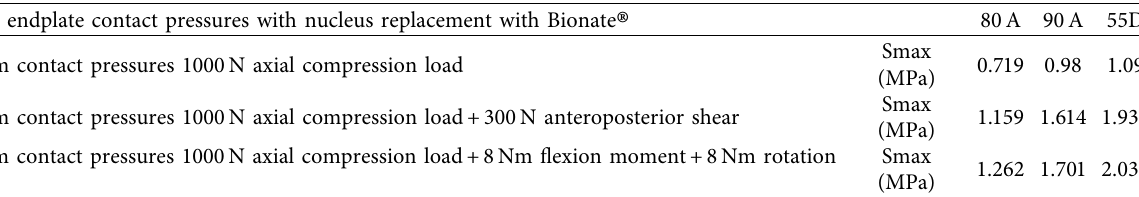
Figure 7: Annulus Z -axis stresses with the selected design Bionate ® nucleus replacement 80A, 90A, and 55D. Table 3: Te vertebral endplates’ maximum contact pressures with the selected design nucleus replacement made of Bionate ® 80 A, 90A, and